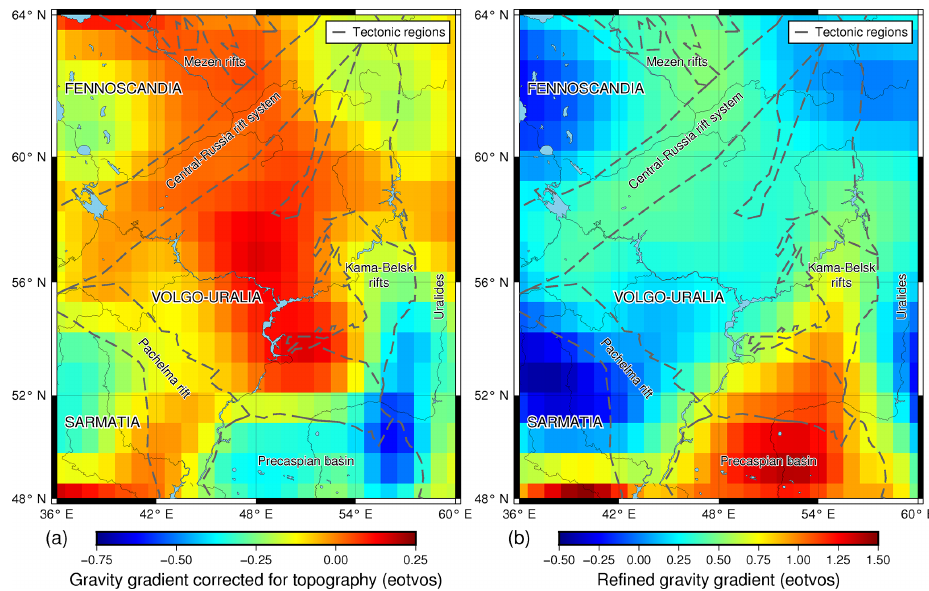
Figure 4. (a) Vertical gravity gradient corrected for topography on the area of Volgo–Uralian region and (b) refined gravity gradient corrected for both topography and the gravity gradient effect of sediments. Dashed polygons represent tectonic regions used in gravity inversion.